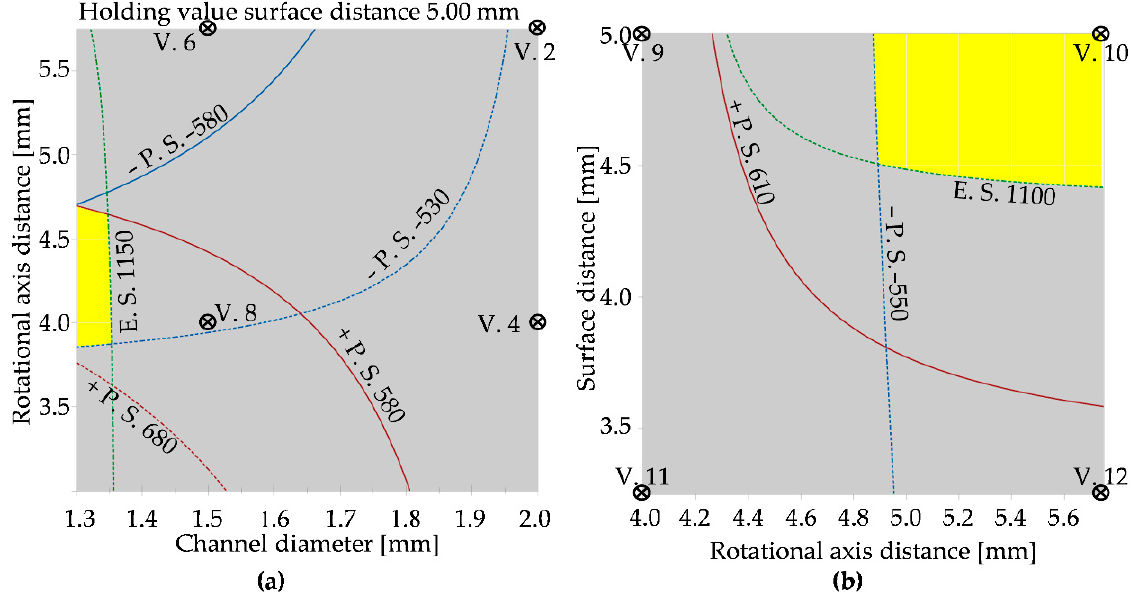
Figure 11. Superimposed contour diagram for the parameter combination with regard to the stresses in the die at 97.5% stroke ( a ) for circular channels and ( b ) for elliptical channels (E. S. = equivalent stress (MPa); +P. S. = max. principal stress (MPa); − P. S. = min. principal stress (MPa); V. = variant; yellow area = target range).